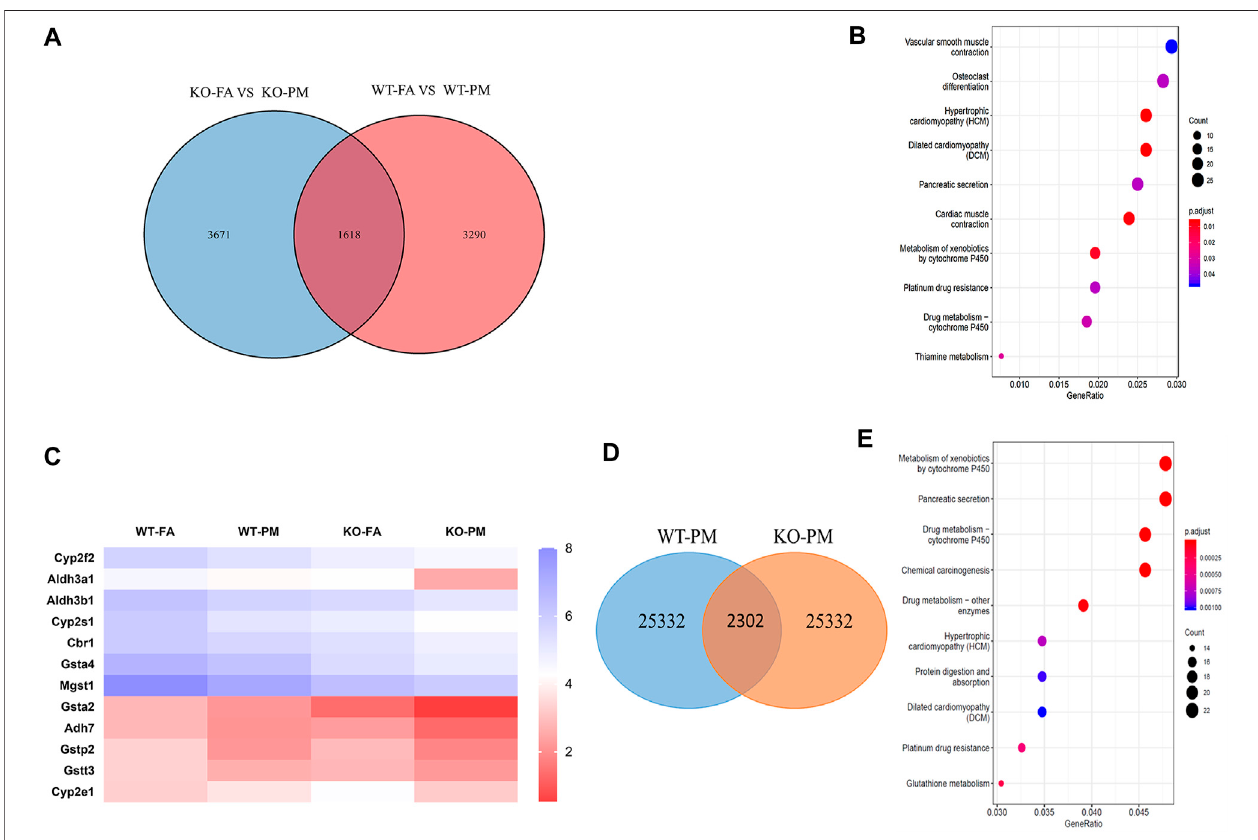
FIGURE3 | CYP450 pathway in involved in lung damage of KO mice after exposureto PM 2.5 . (A) Venn diagram showing the number ofgenesthat fold change > 2 shared by WT-FA vs. WT-PM and KO-FA vs. KO-PM. n (cid:2) 3per group (B) KEGG enrichment of3,671 genes in four groups mice. n (cid:2) 3per group (C) Heatmap for all the samples of “ Metabolism of xenobiotics by cytochrome P450 ” pathway. n (cid:2) 3 per group (D) The Venn diagram of 2,302 DEGs were identi fi ed in KO-PM mice relative to WT-PM mice. n (cid:2) 3 per group (E) The top-10 KEGG pathway enrichment of 2,302 DEGs were identi fi ed in KO-PM mice relative to WT-PM mice. n (cid:2) 3 per group. FA, fi ltered air; PM, fi ne particulate matter. WT, wild type mice; KO, Nrf2 − / −